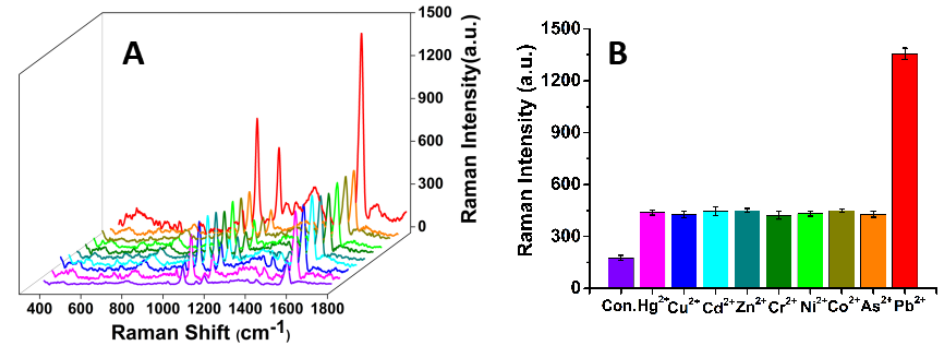
Figure 5. Specificity test with various metal ions. ( A ) SERS spectra of 4-ATP in the presence of different metal ions; the concentration of Pb 2+ was 1 ng mL − 1 , whereas for the other metal ions it was 100 ng mL − 1 . ( B ) Bar chart based on the Raman intensities at 1582 cm − 1 .